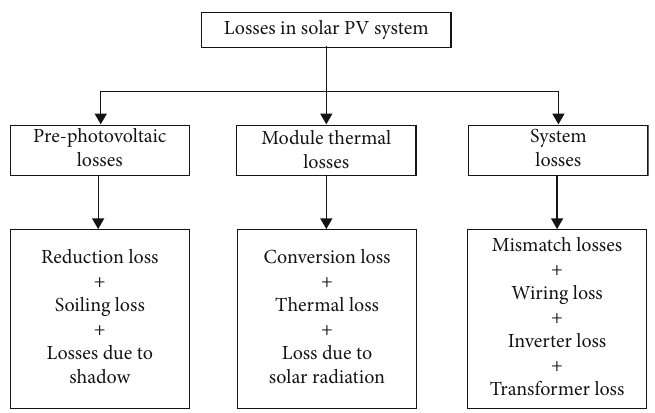
Figure 4: Losses associated in solar photovoltaic system